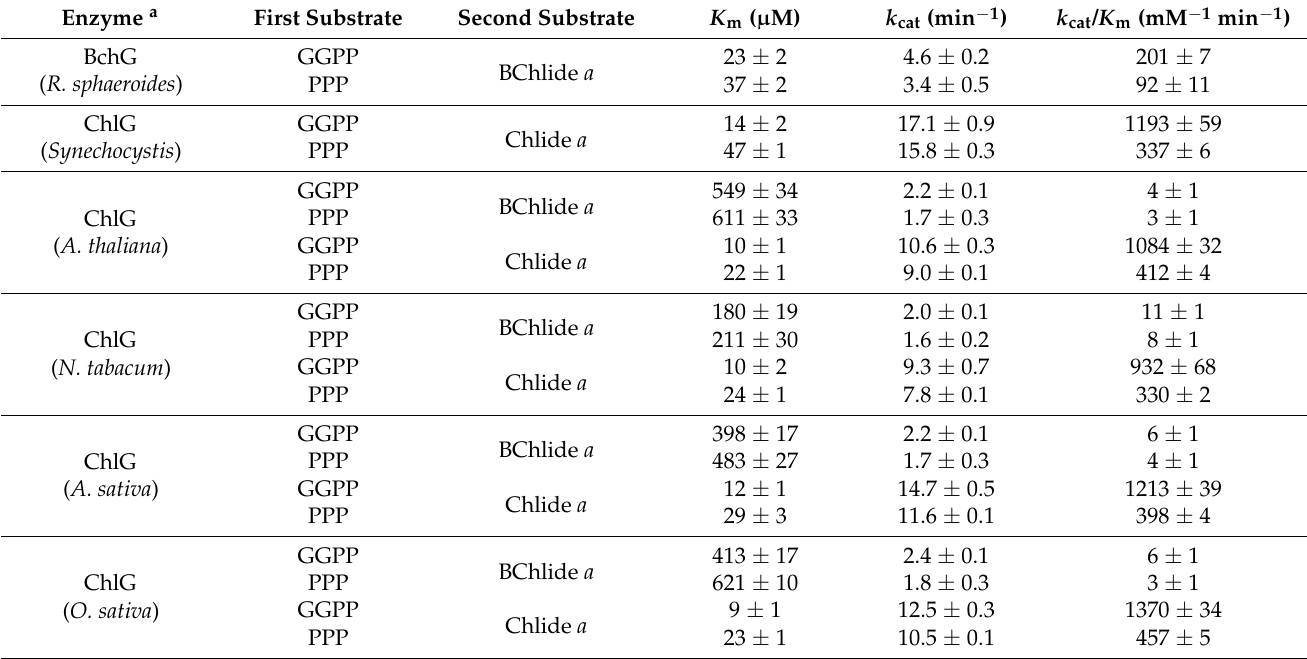
Table 2. Kinetic parameters of BchG and ChlGs for BChlide a and Chlide a